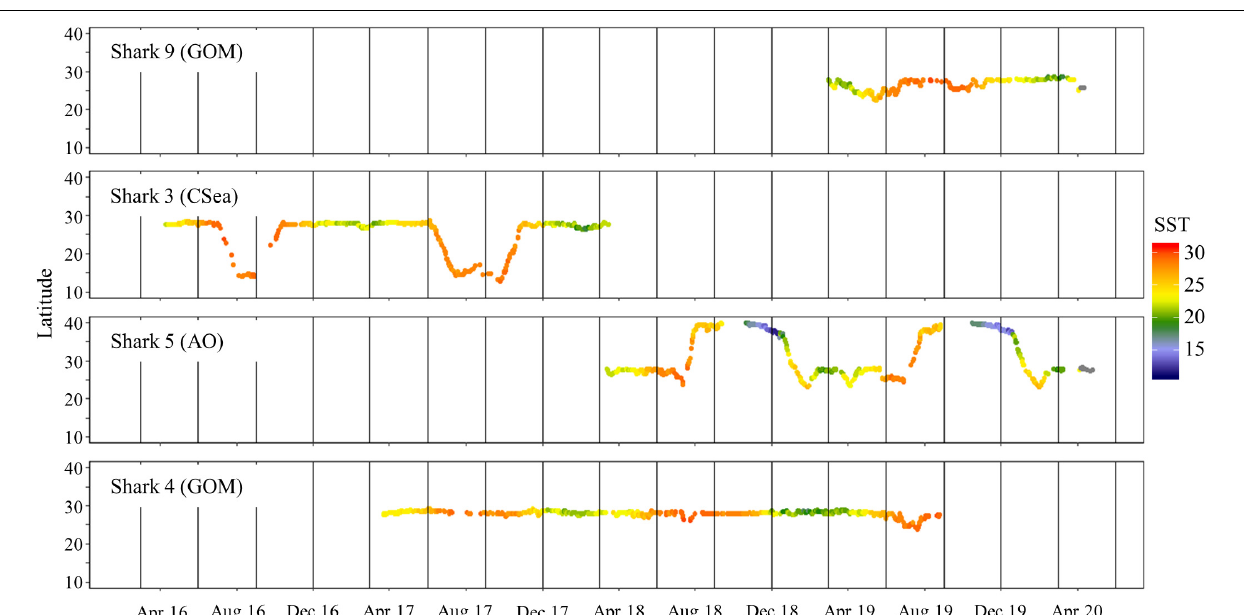
FIGURE 7 | Daily latitude estimates and associated sea surface temperature (from satellite remote-sensing data; ◦ C) for four shortfin makos tracked for > 1 year in the western North Atlantic Ocean. Sharks 4 and 9 remained in the Gulf of Mexico while sharks 3 and 5 migrated out of the Gulf of Mexico. Destinations (GOM, Gulf of Mexico; AO, Atlantic Ocean; and CSea, Caribbean Sea) of mako sharks after migration are in parentheses. Vertical lines represent the start of each season: summer (June–August), fall (September–November), winter (December–February), and spring (March–May). TABLE 3 | Mean sea surface temperature ( ◦ C) and ambient depth (m) with standard deviations for mako sharks tracked in this study. SST Depth Season Male Female Male